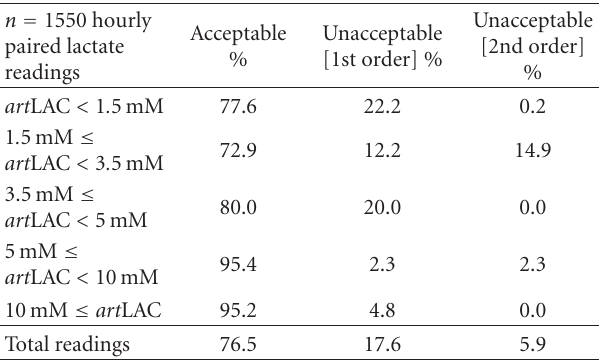
Table 2: Clinical evaluation of absolute subcutaneous adipose tis- sue versus arterial blood ( art LAC) lactate concentrations stratified for individual lactate ranges according to Figure 1(a).